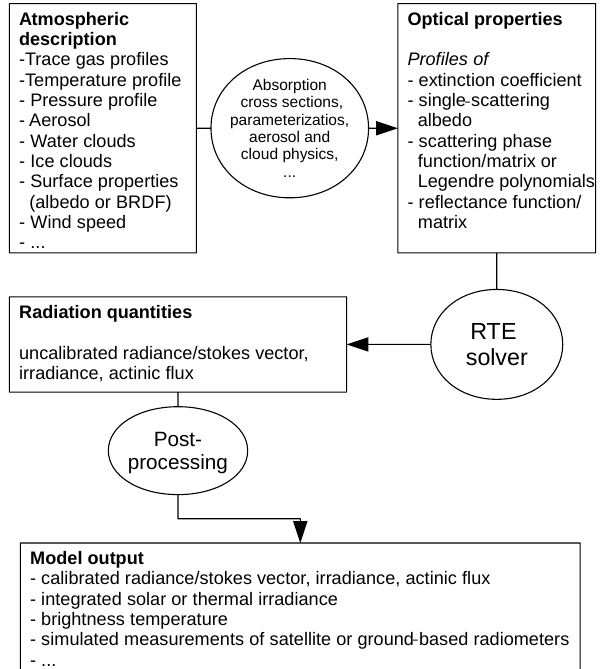
- brightness temperature - simulated measurements of satellite or ground based radiometers - ... Figure 1. Structure of the uvspec radiative transfer model.